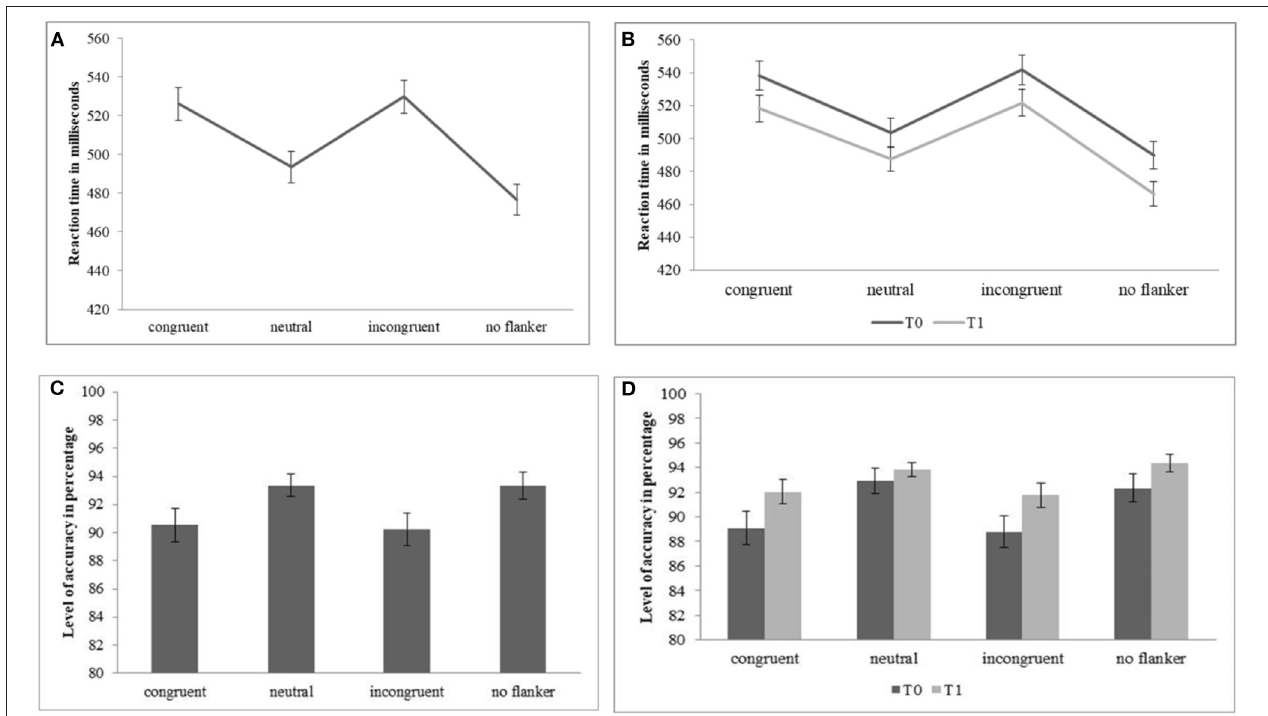
FIGURE 2 | Mean and SD (vertical lines) relative to the reaction time in milliseconds and the level of accuracy in percentage registered at the Flanker’s test. Specifically, in panels (A,C) , the data in relation to the four experimental conditions are shown; in panels (B,D) , the data in relation to the four experimental conditions split for the two measurements (T0 vs. T1) are shown.